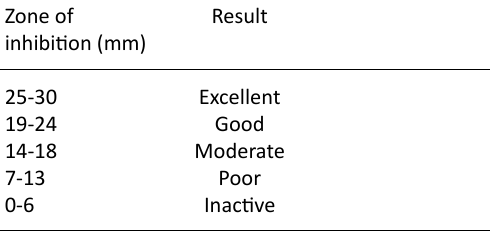
Table 4. Antibacterial activity of crude extract, fractions and nanoparticles of D.salicifolia Microorganism Gram Crude n-Hexane CHCl3 EtOAc AuNPs